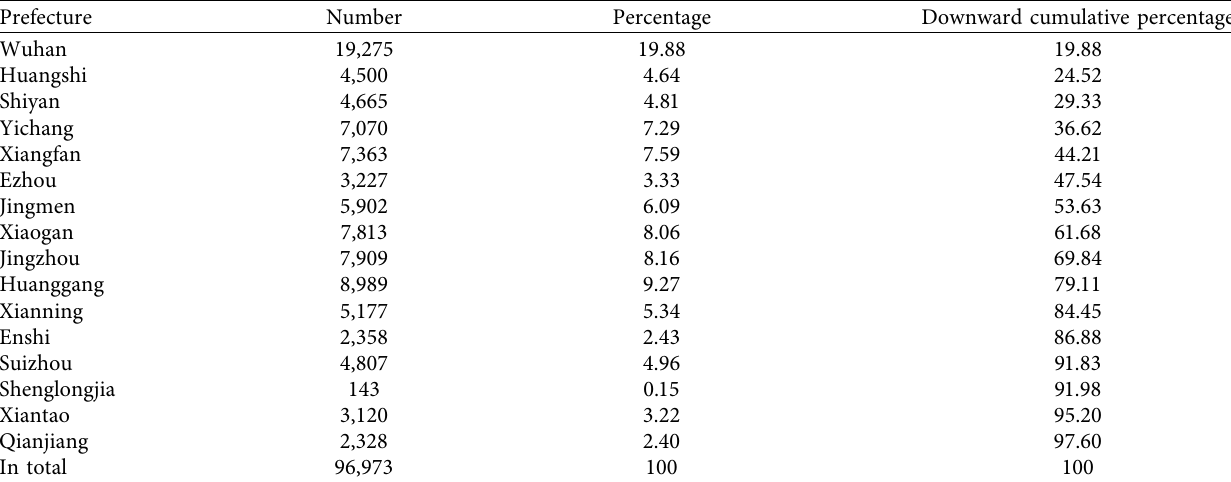
Table 2: Distribution of industrial enterprises in the 17 prefectures of Hubei.